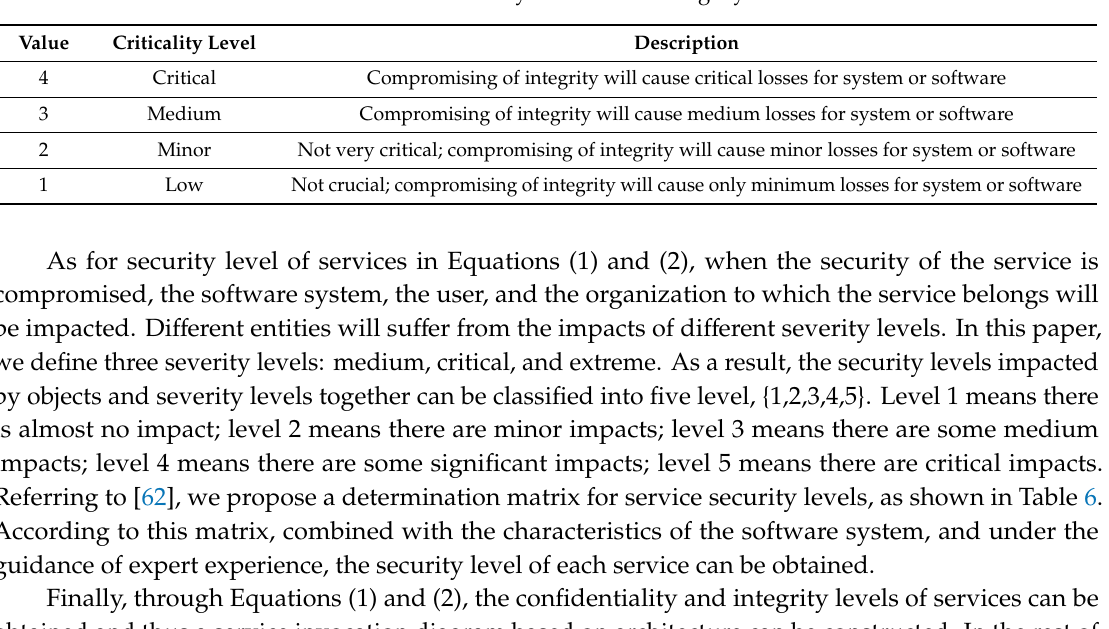
Table 5. Criticality level of data